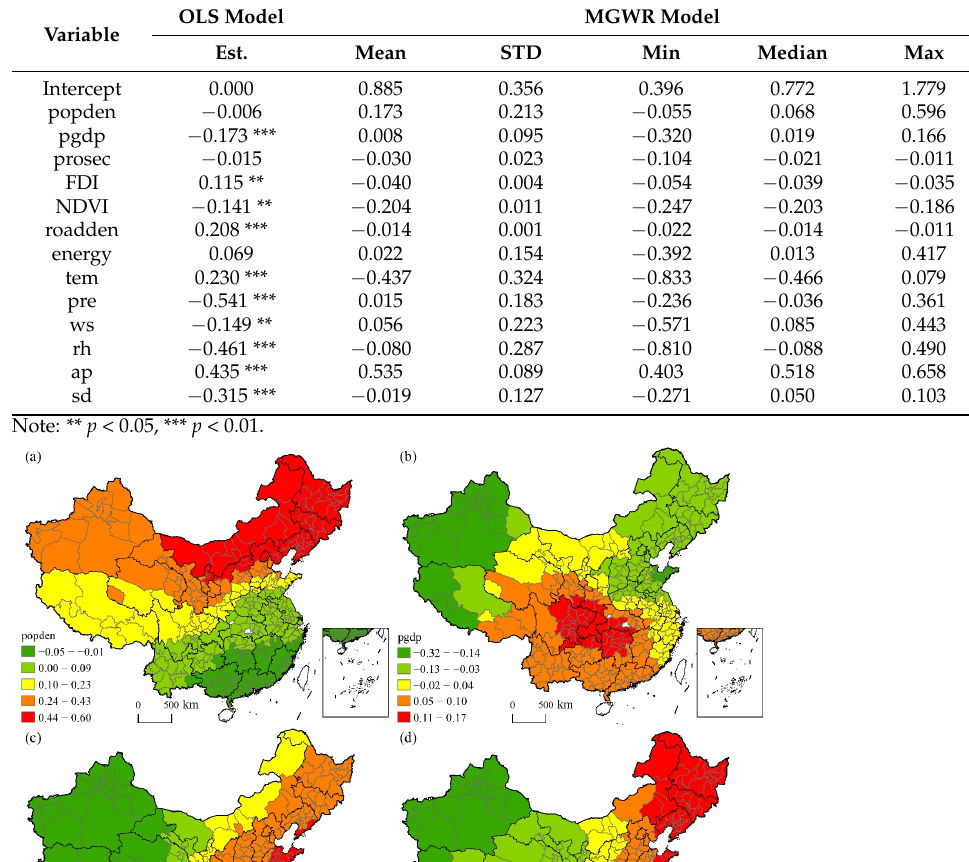
Table 5. Comparison of regression parameters between OLS and MGWR models.